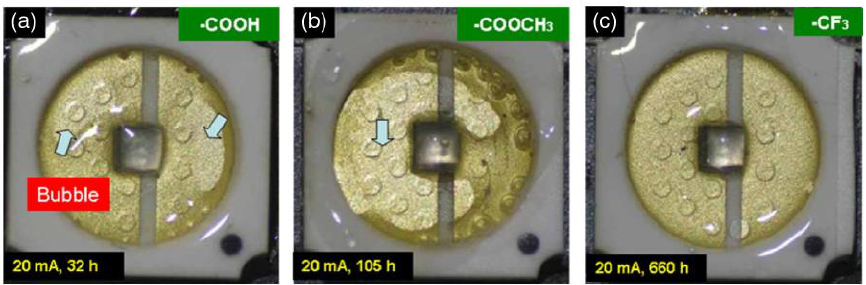
Figure 7. Bubbles appearing after reliability tests for 32, 105, and 660 h followed by heating up to 230 °C for the p-BVE with –COOH, –COOCH 3 , and –CF 3 end groups, respectively. Reliability tests were conducted using 265-nm LEDs at operation current of 20 mA [86].